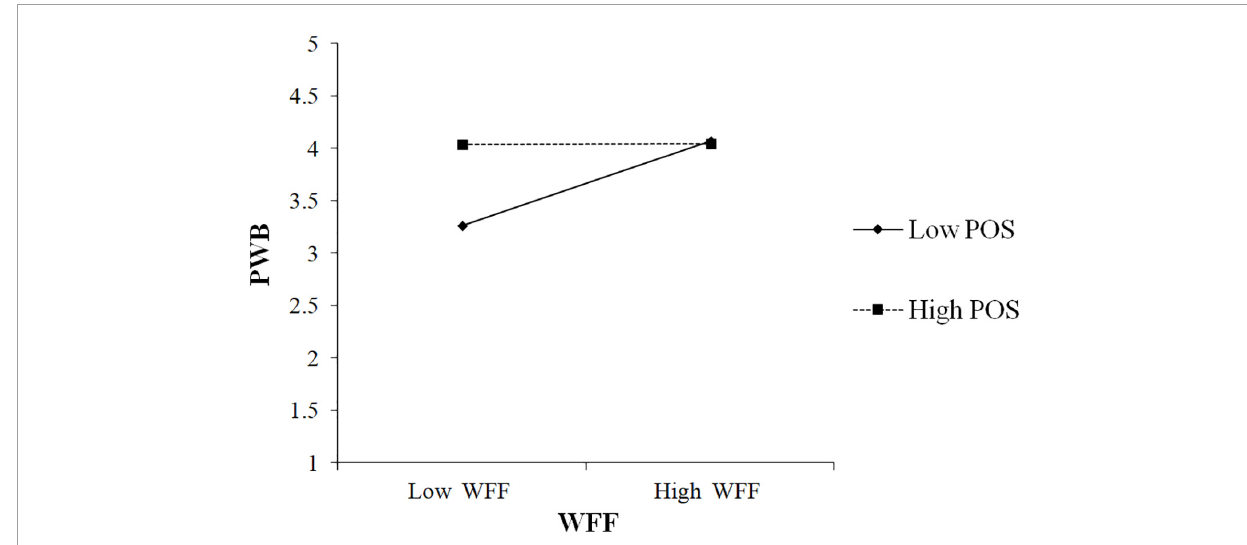
FIGURE4 Effects of work-family facilitation (WFF) and POS on PWB.